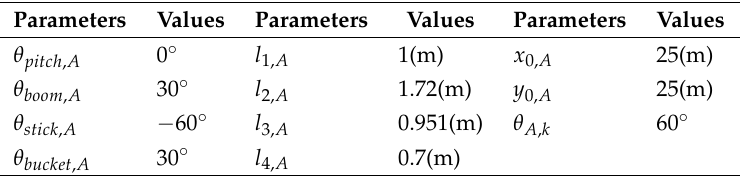
Table 1. Posture Parameters of Simulation: A.